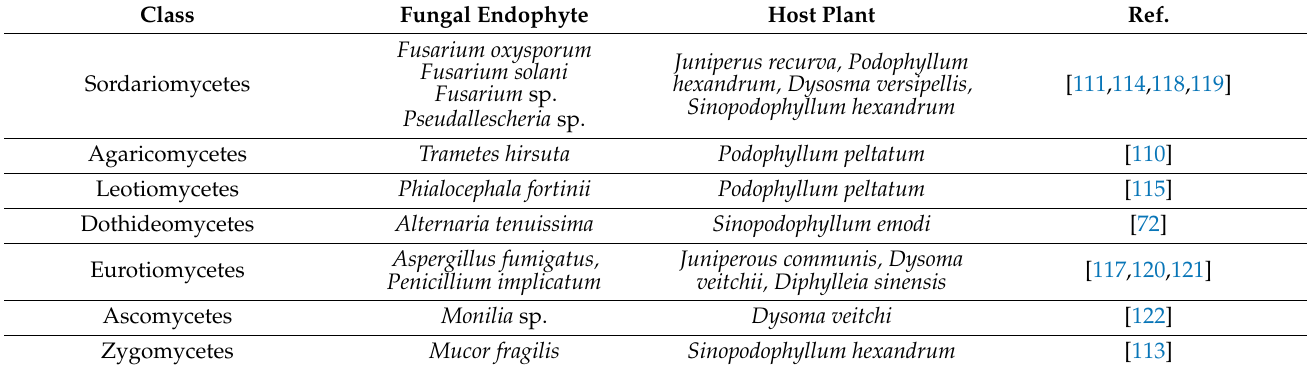
Table 2. Various fungal sources reported as sources of podophyllotoxin.